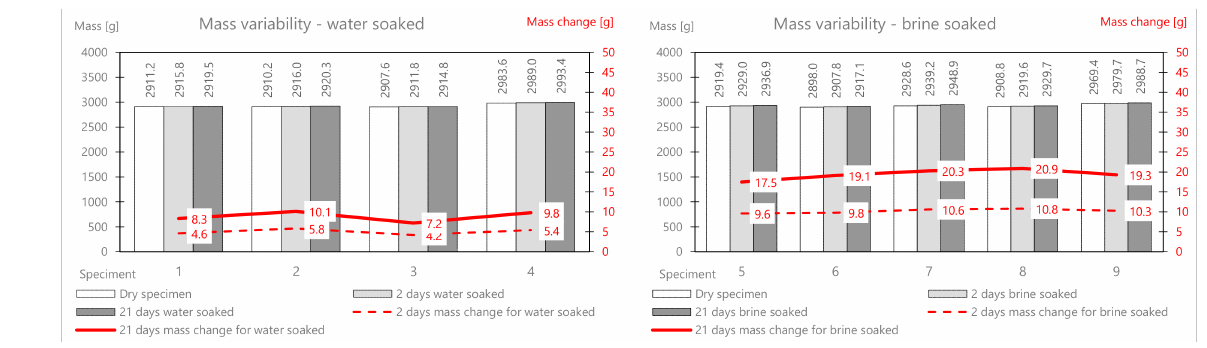
Figure 7. ACWMS22(Pmb) mix mass variability.